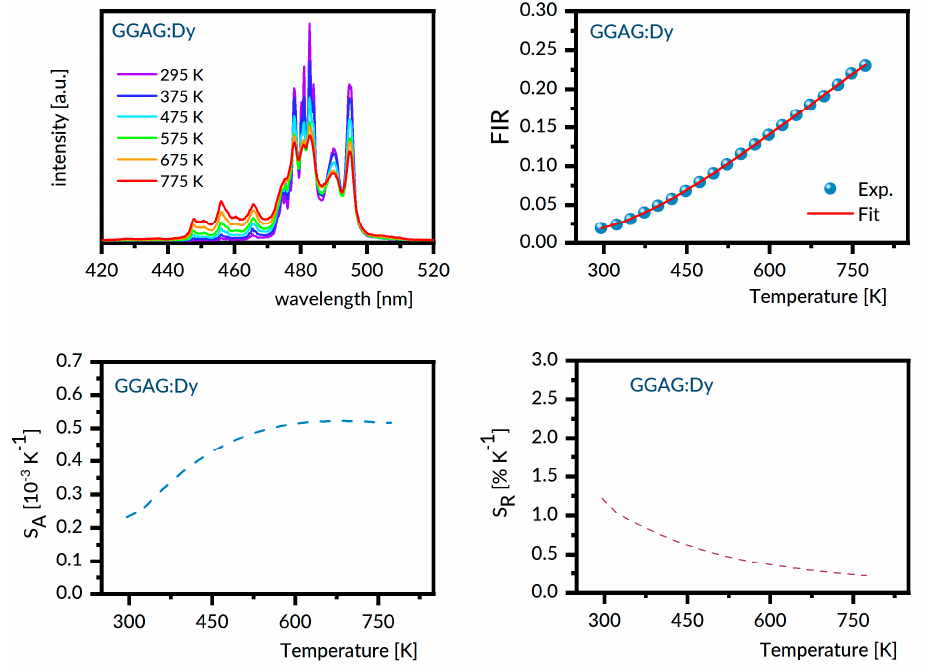
Figure 6. GGAG:Dy emission spectra recorded at several different temperatures ( upper left ), the plot of FIR versus temperature ( upper right ), the temperature dependence of S A ( lower left ), and the temperature dependence of S R ( lower right ).